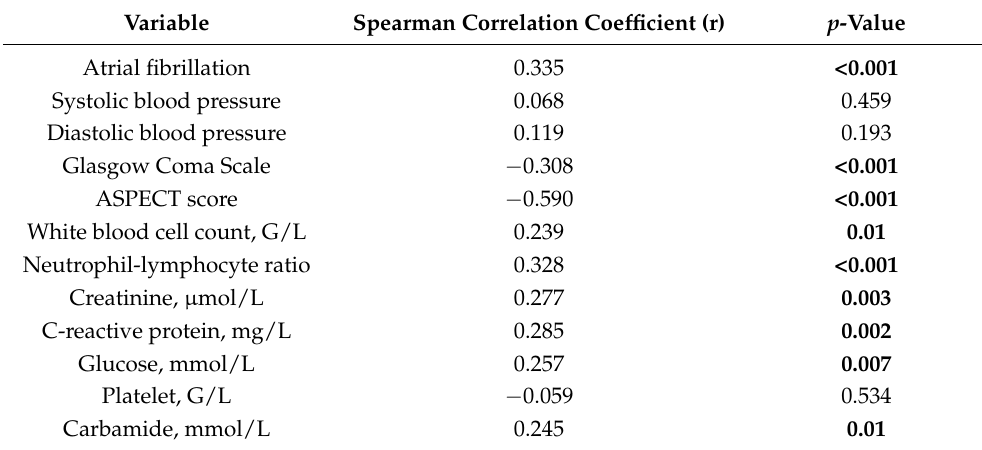
Table 2. Spearman correlation between admission clinical parameters and serum periostin level measured at 24 h after admission. Coefficient (r) values > 0 indicate a positive association; values < 0 indicate a negative association. Statistically significant values are given in bold. ASPECT, Alberta stroke program early CT score.